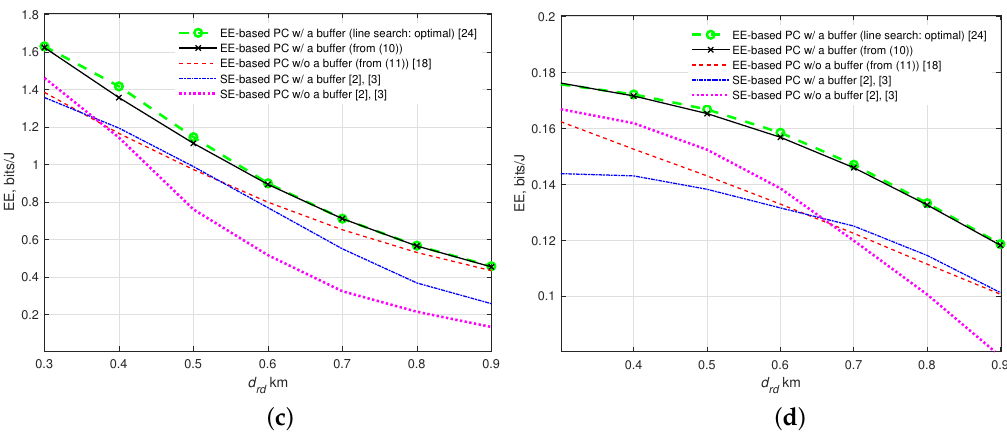
Figure 9. EE across d rd for RN with a power control (PC) for RN. ( a ) P c = 10 dBm. ( b ) P c = 20 dBm. ( c ) P c = 30 dBm. ( d ) P c = 40